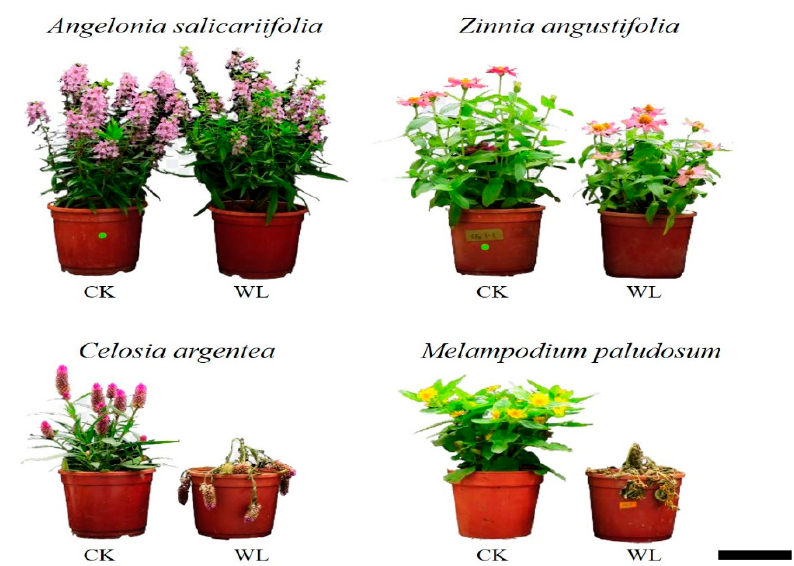
Figure 2. Effects of waterlogging on the performances of angelonia, narrow-leaf zinnia, celosia, and medallion flower plants. All plants were treated with 10 days of waterlogging followed by a seven-day recovery (WL treatment). Control plants remained well-irrigated condition (60% soil moisture, CK) throughout the experiment. Bar = 10 cm.